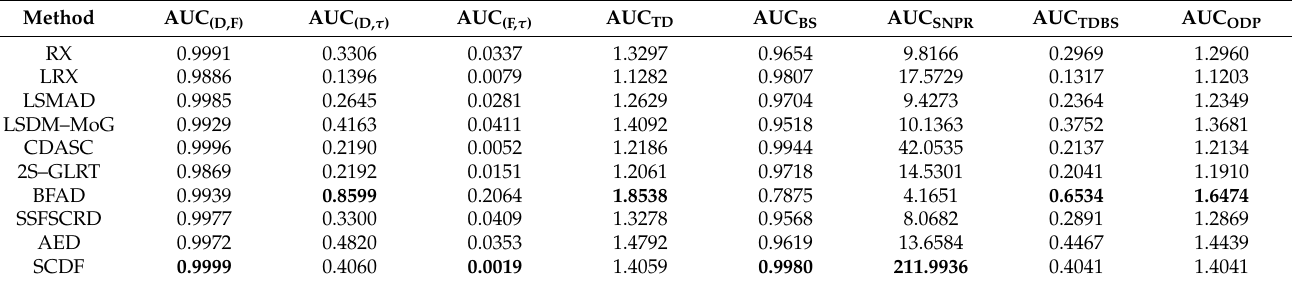
Table 5. Comparison of AUC performance of different methods on the Chikusei